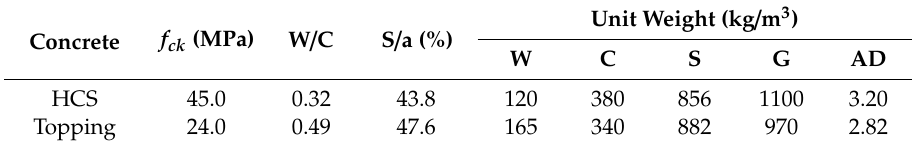
Table 1. Concrete mix